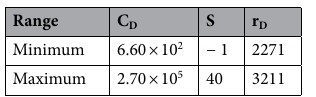
Table 2. Range of characteristics considered for data simulation.